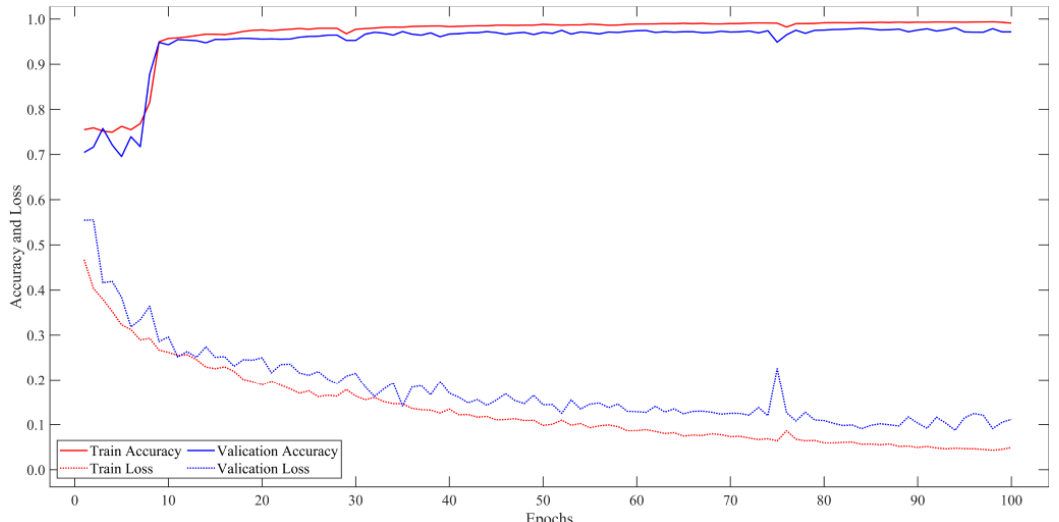
Figure 6. The Accuracy and Loss of DMU-Net for training the GF-7 self-annotated building